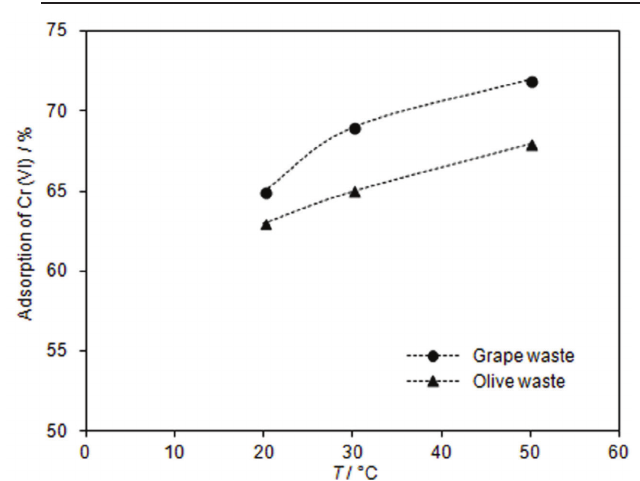
Fig. 10 – Effect of temperature on Cr(VI) adsorption on grape and olive waste (γ